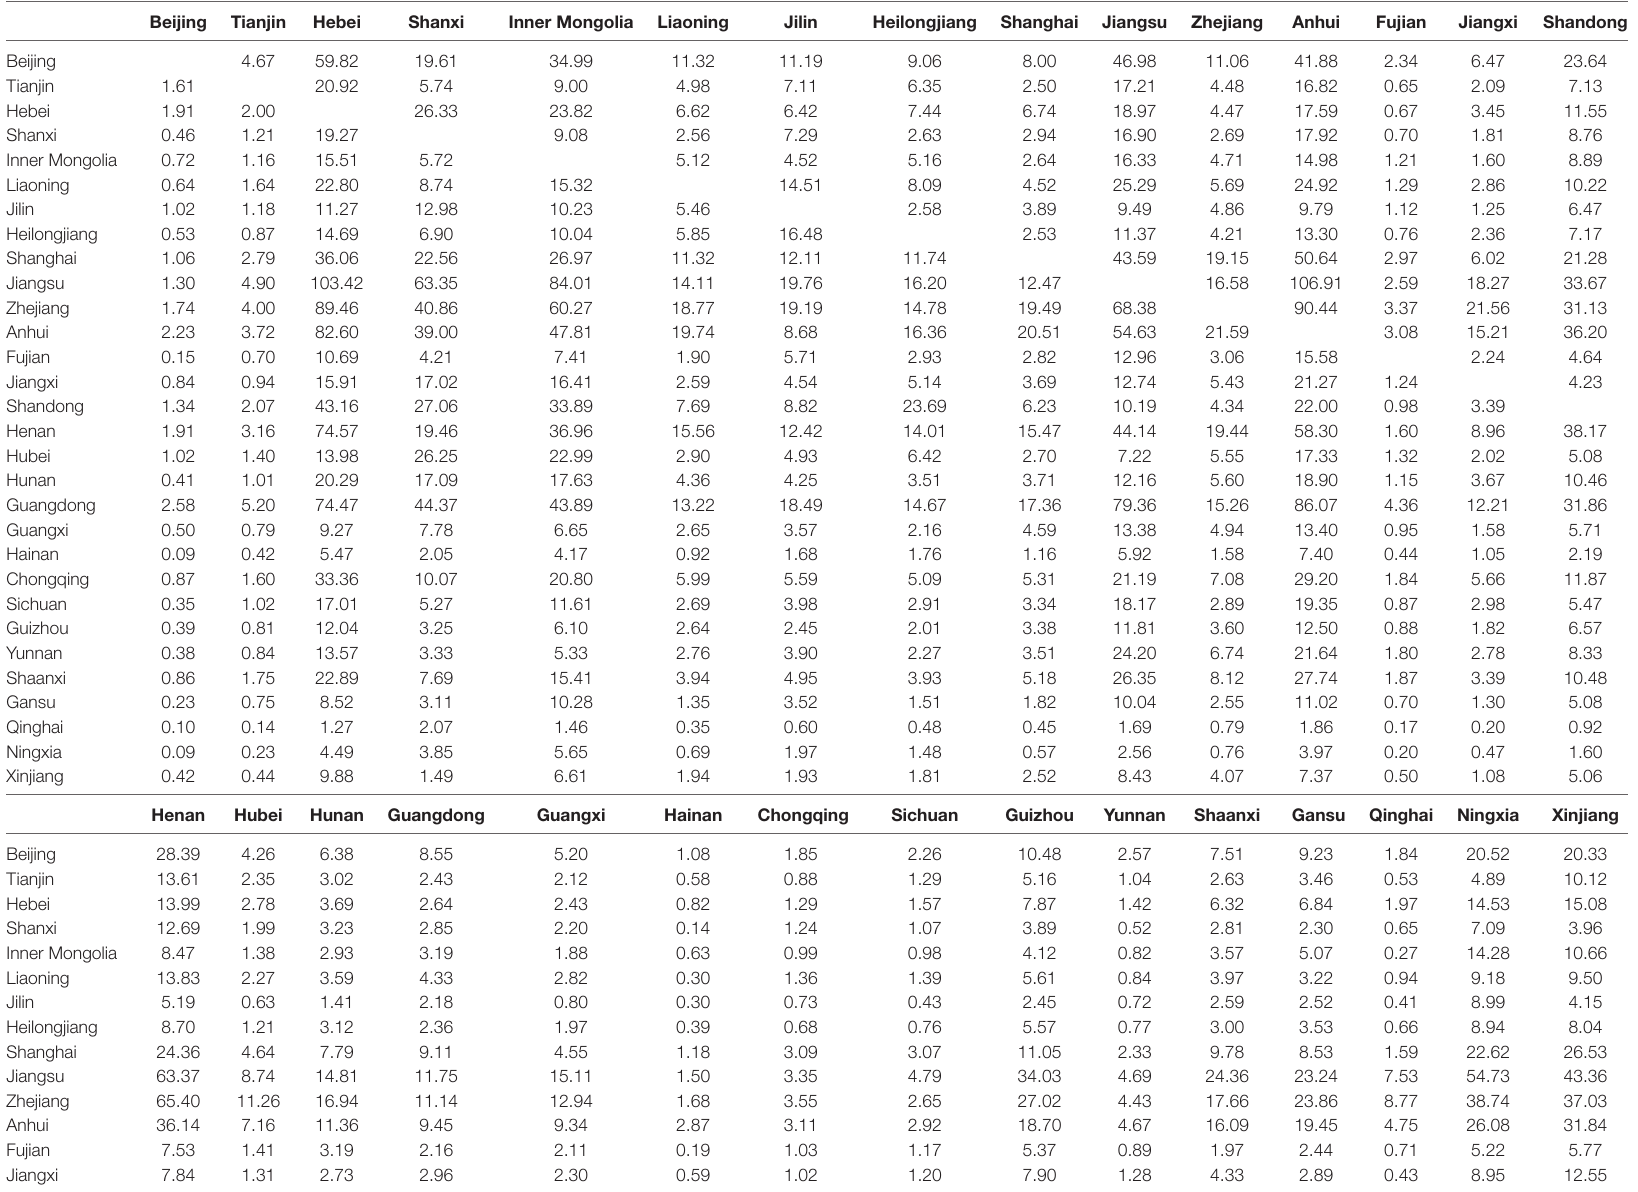
TABLE 2 | Details of multi-regional CO 2 emissions transfer for consuming intermediate and final